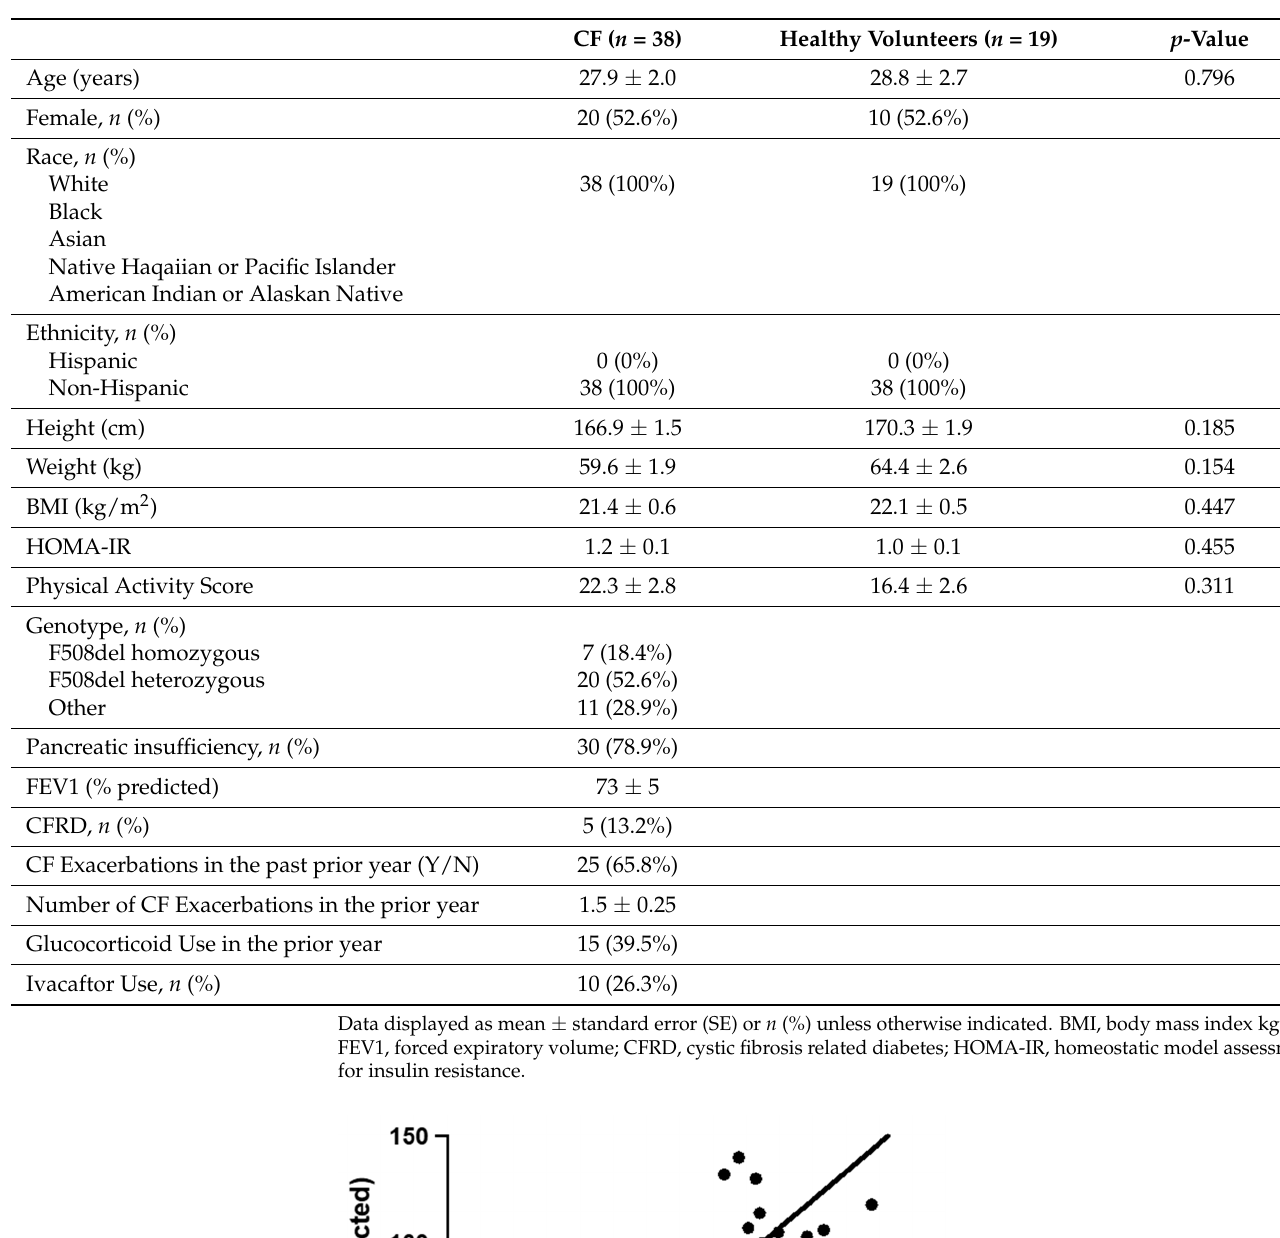
Table 1. Clinical Characteristics.